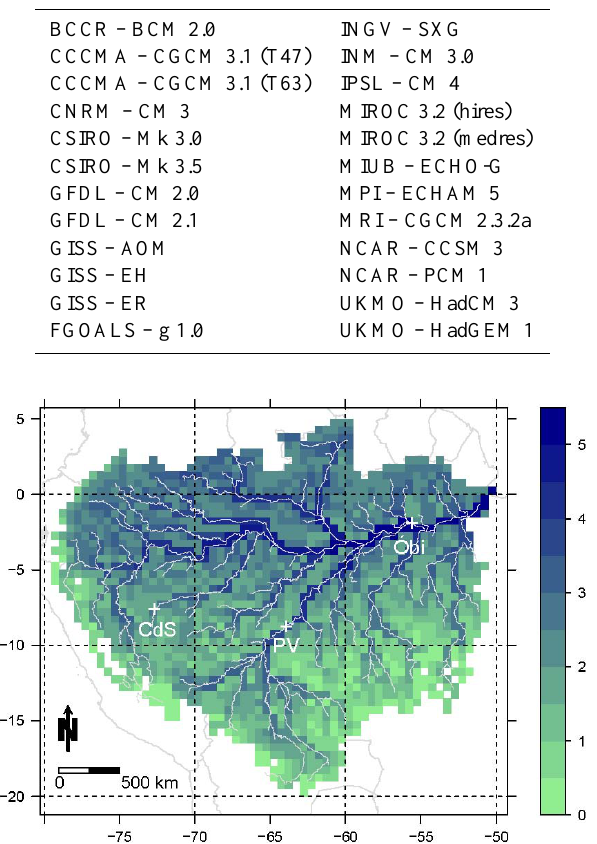
Fig. 1. Simulated mean discharge [logm 3 s − 1 ] during June, aver- aged over the reference period 1961–1990. The white crosses indi- cate the exaple sites Cruzeiro do Sul (CdS, ID 3), Porto Velho (PV, ID 41), and ´Obidos ( ´Obi, ID 10 and 42).